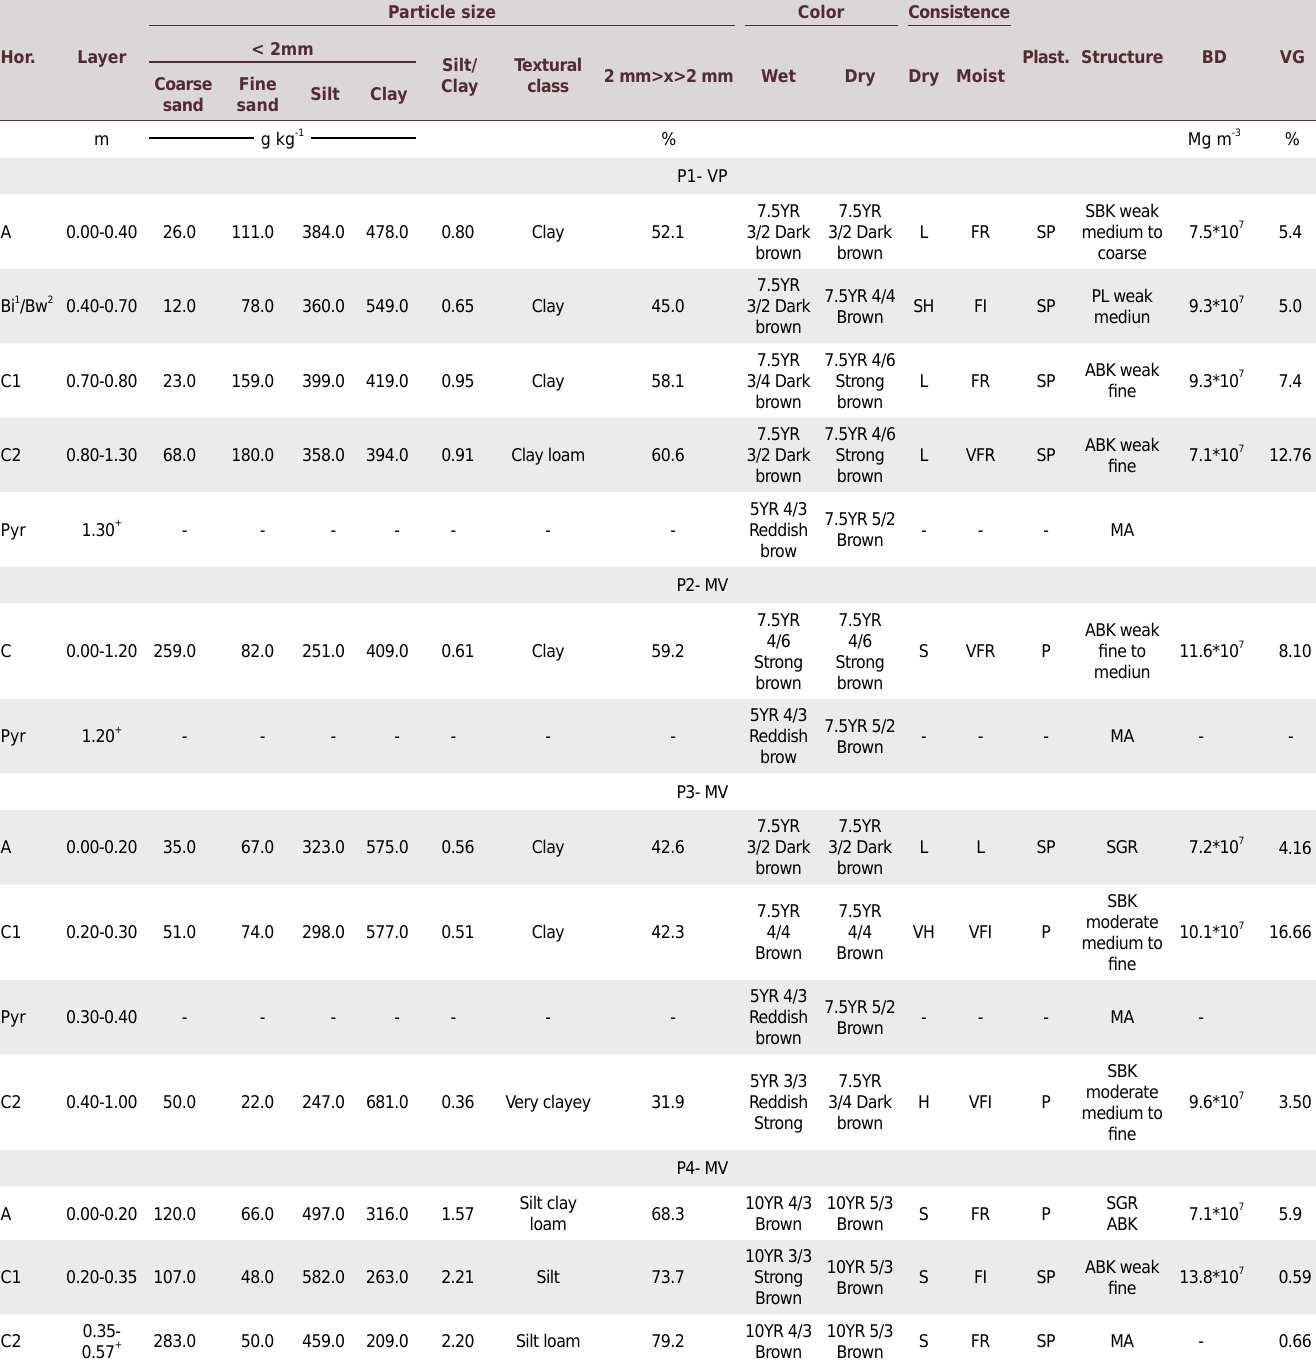
Table 1. Physical properties of Trindade Island soils